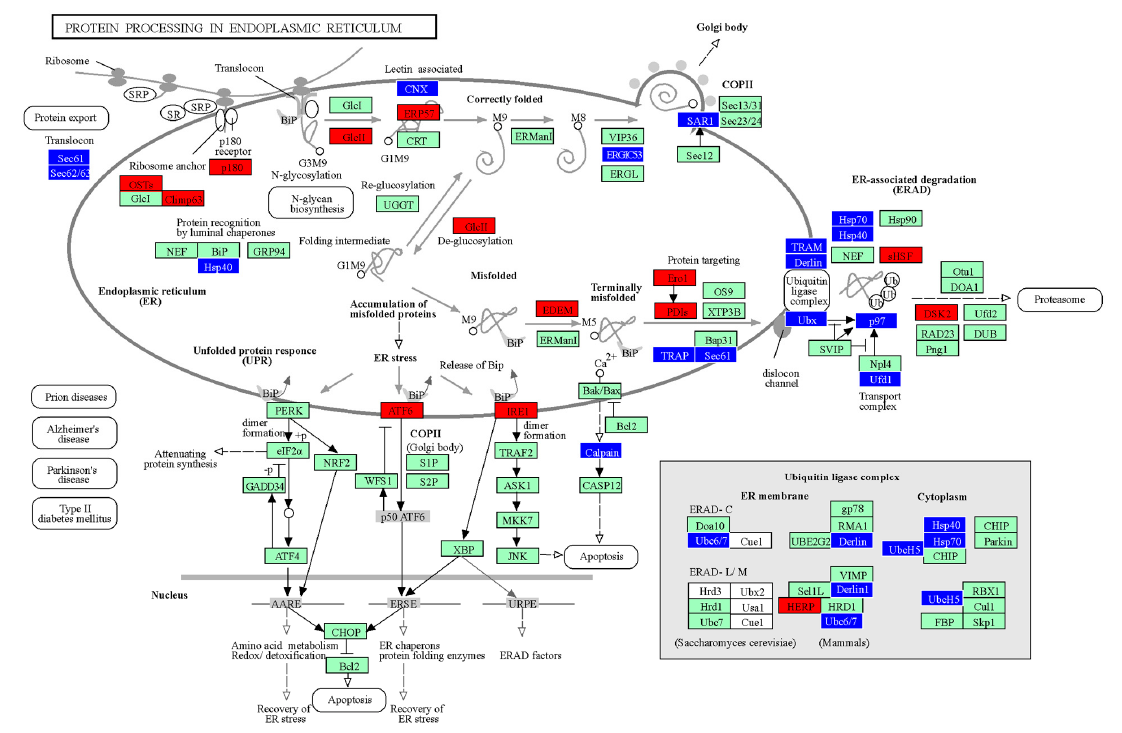
Figure 7. Changes in protein processing in MPS cells. The KEGG pathway presenting the ‘protein processing in endoplasmic reticulum’ process, imaged from transcriptomic data derived from MPS cells. Individual proteins or groups of proteins were colored if a change in the expression of an indicated gene was observed in at least one type/subtype of MPS. Down ‐ regulated and up ‐ regulated genes are marked in blue and red, respectively. Non ‐ marked values indicate results in which no statistically significant differences between MPS and HDFa were determined.